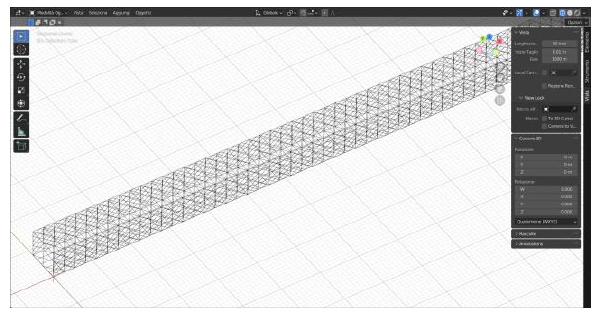
Figure 8 . The 1d modelling of the six bridges over the Po. Figure 9 . The 1d modelling of the bridge in Casalmaggiore.